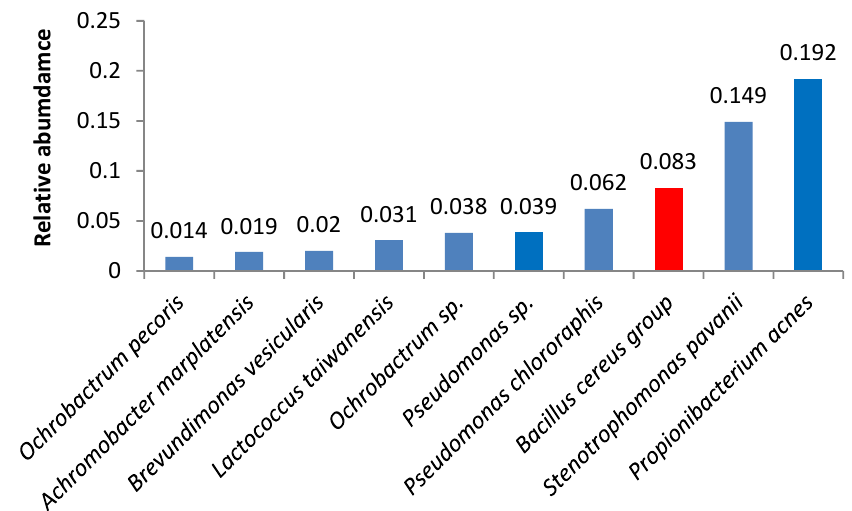
Figure 3. Relative abundance of amplicon sequence variants in butter sample no. 3.